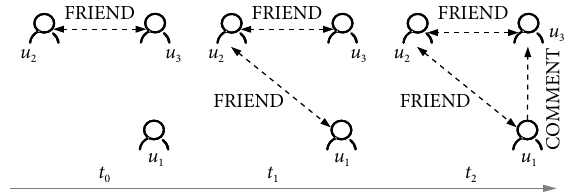
Fig. 2 Sample of the 2nd-order neighbor with type